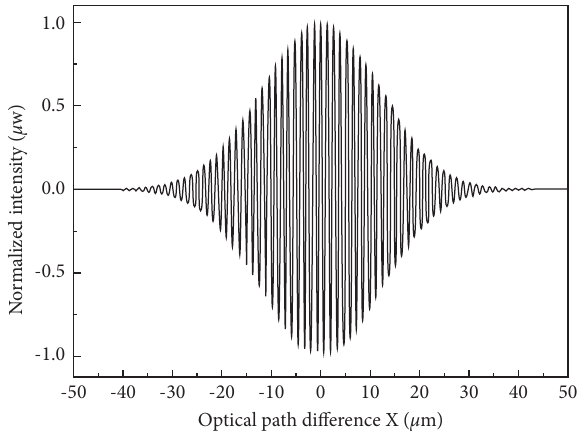
Figure 2: White light interference